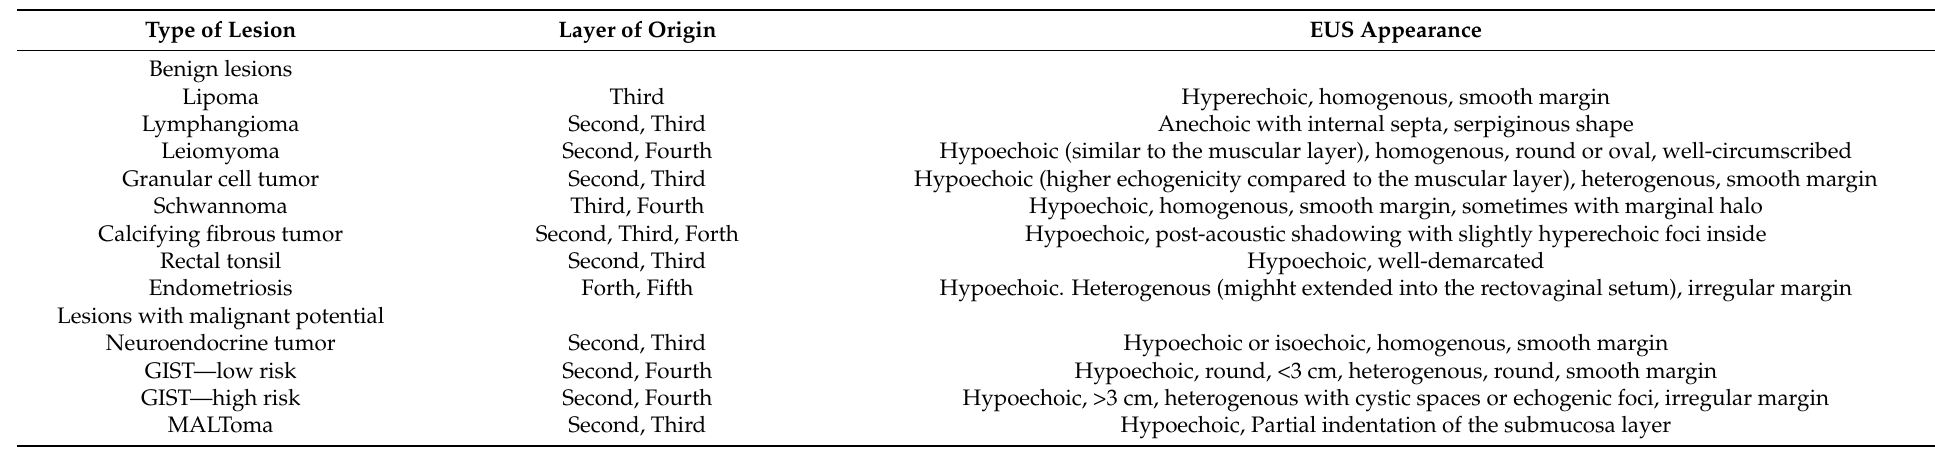
Table 3. Characteristic features of colorectal subepithelial